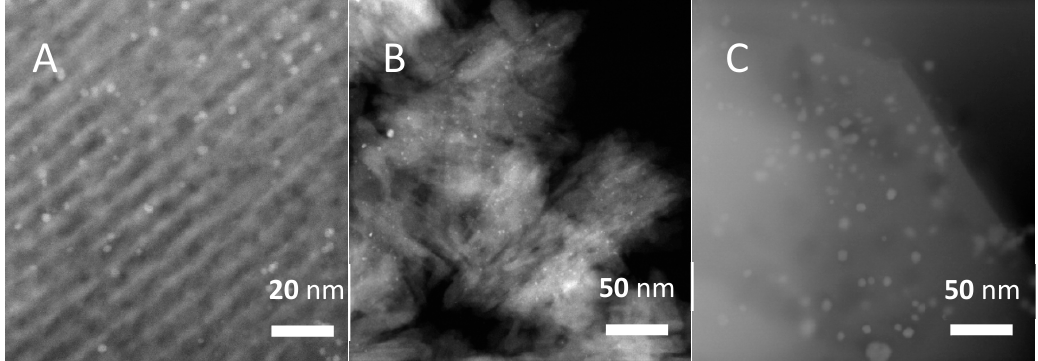
Figure 1. HRTEM images of ( A ) 1%Pt/SBA-15, ( B ) 1%Pt/MFI(NS), and ( C ) 1%Pt/DeAl-Hbeta (2 – 8 nm).